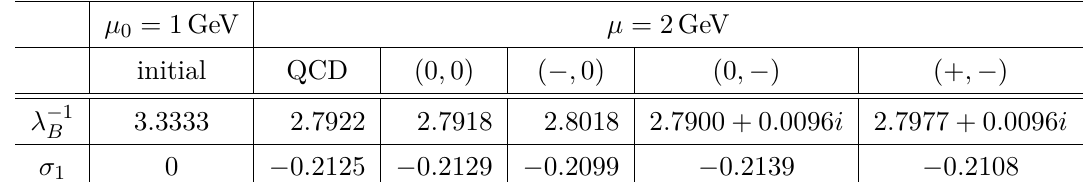
Table 1 . Numerical values of λ − 1 for the exponential